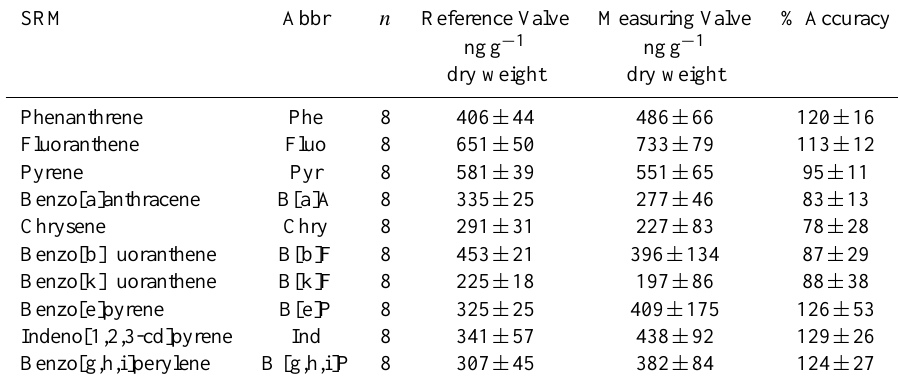
Table A4. Accuracy test withSRM 1941b.